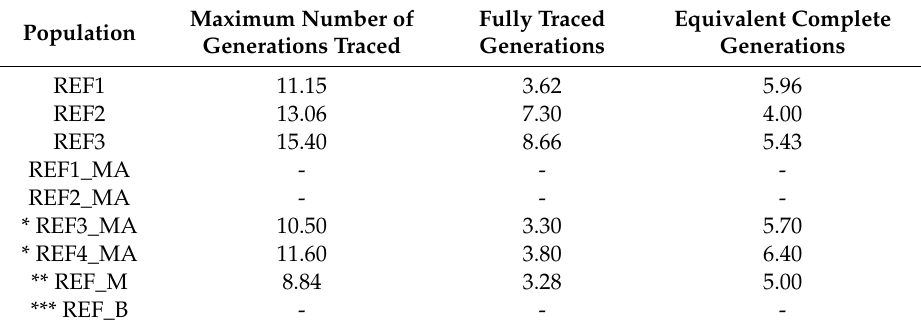
Fully Traced Equivalent Complete Generations Generations